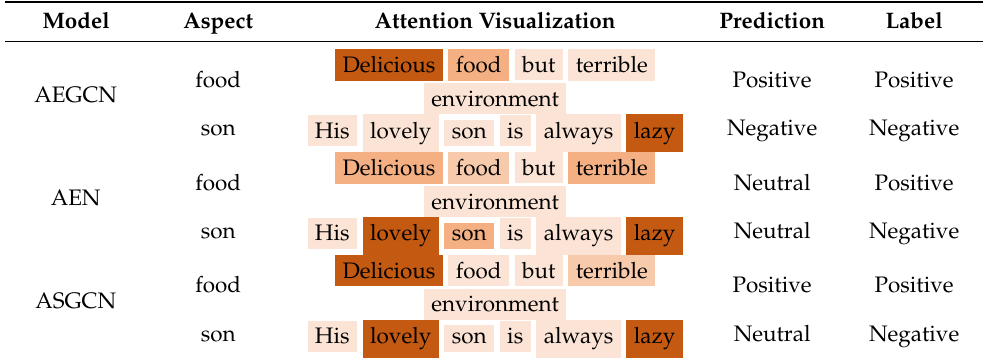
Table 4. Visual analysis cases of ASGCN, AEN, and AEGCN. Model